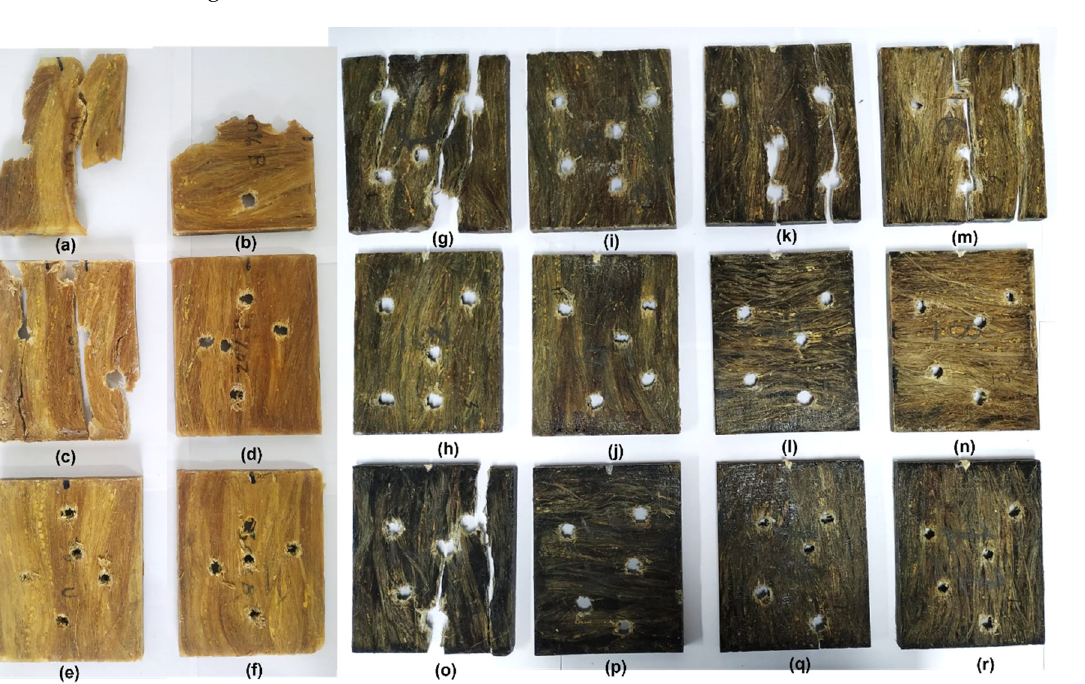
Table 4. Values acquired from the absorption energy tests. Samples